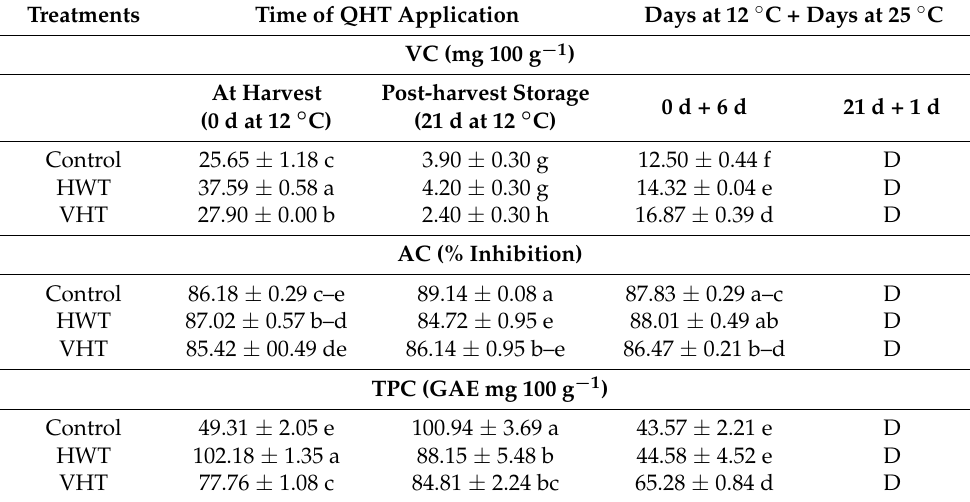
Table 2. Effect of the heat treatments applied at harvest and post-harvest storage on vitamin C content (VC), antioxidant capacity (AC), and total phenolic content (TPC) of mango fruits. Data are presented as mean ± SE ( n = 3 ). Different letters indicate significant differences according to LSD at p ≤ 0.05.